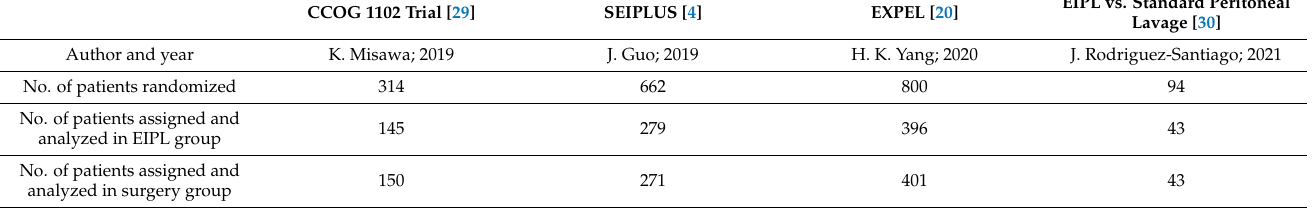
Table 2. Recent studies on extensive intraperitoneal lavage in GC